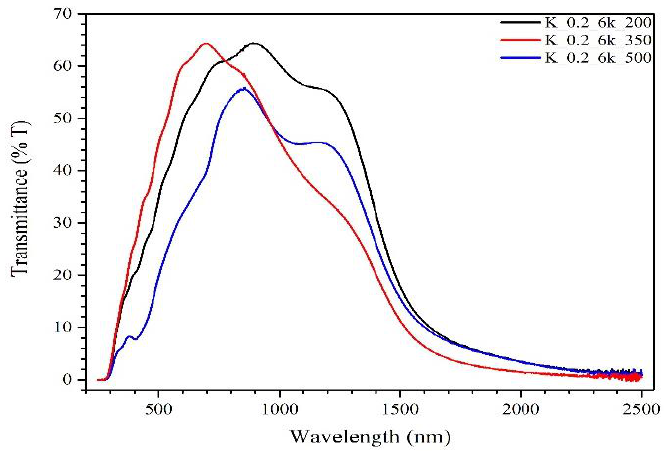
Figure 7. UV–vis spectroscopy of CZTS thin films at different TT temperatures: black line, 200 °C; red line, 350 °C; and blue line, 500 °C.